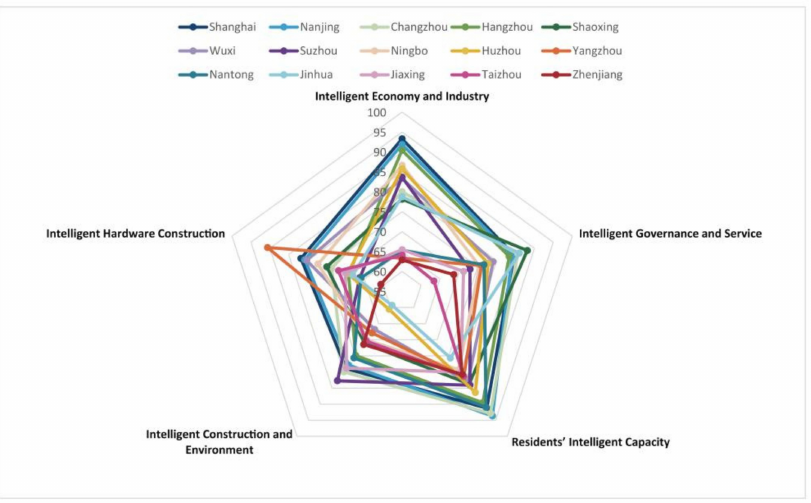
Figure 6. Comparison of the five dimensions of the fifteen major cities in the Yangtze River Delta region,